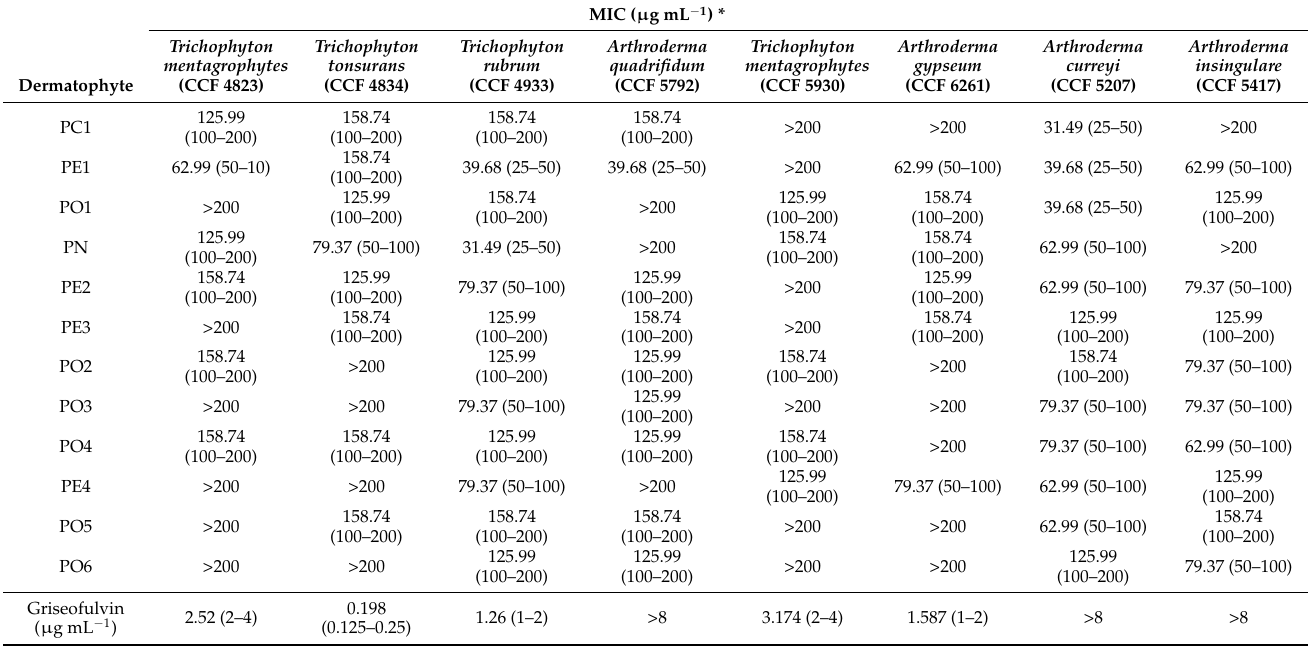
Table 11. Minimal inhibitory concentrations (MICs) of Pleurotus mycelia (S2) extracts against der- matophyte